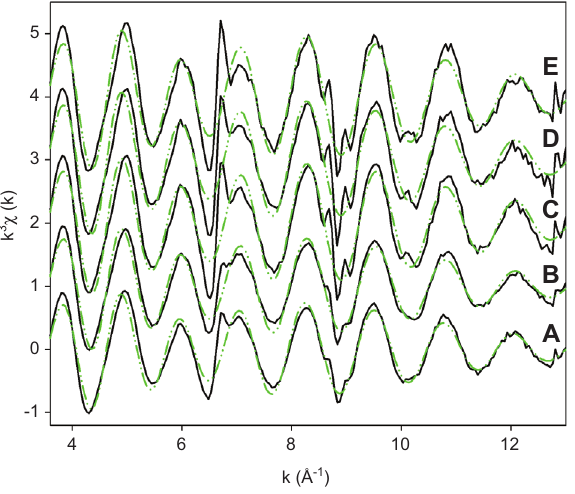
Figure 9 EXAFS spectra of the samples Pd7 (A), Pd13 in ethylene glycol (B), Pd13 in isopropanol/water (C), Pd13 in isopropa- nol/water at 50 ° C (D), Pd13 in isopropanol/water at 50 ° C with 3 bar synthetic air (E). The experiment is shown in black, the fit in